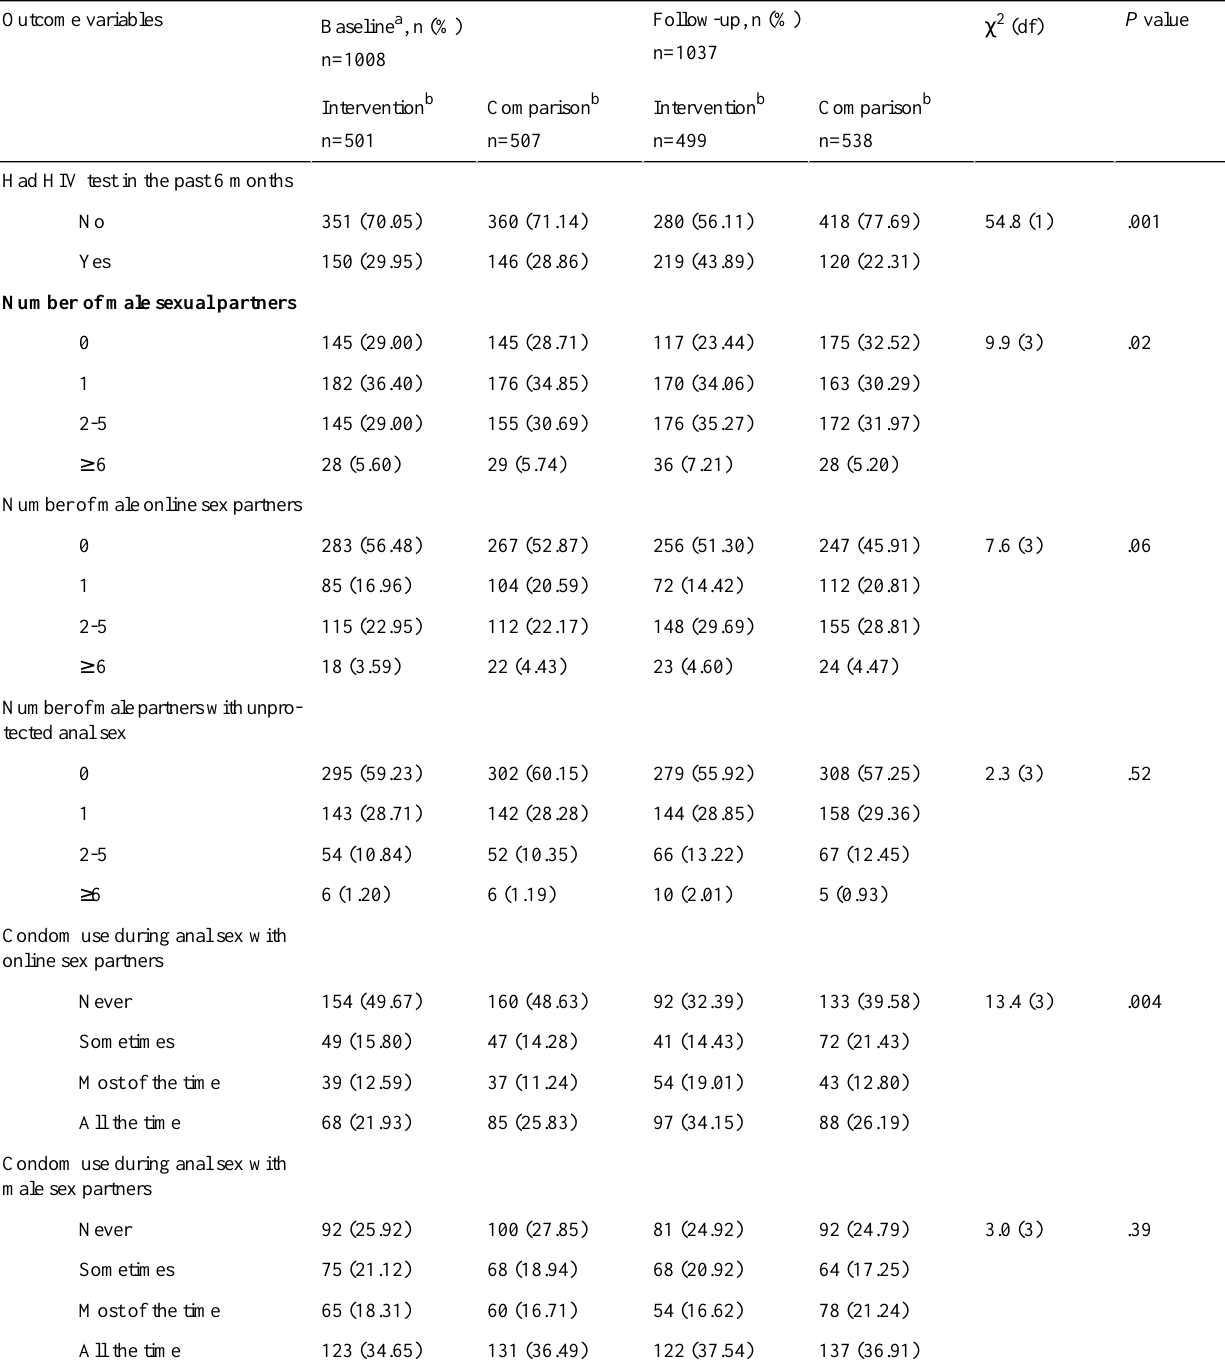
Table 3. Intervention effects on HIV testing and sexual behaviors within the previous 3 months among Internet-using MSM.